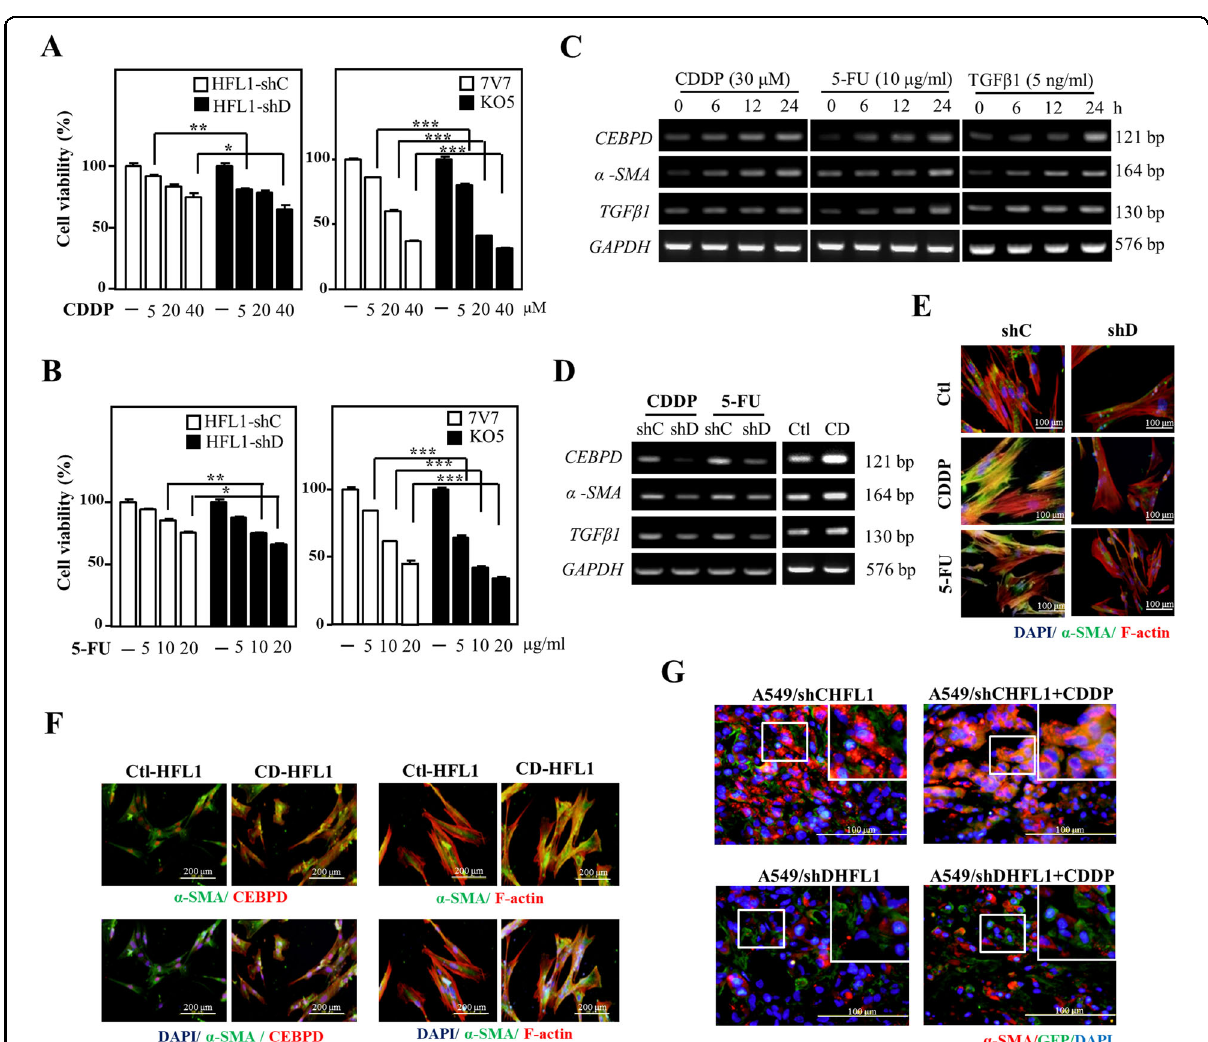
Fig. 1 CDDP and 5-FU induce CEBPD and contribute to myo fi broblast differentiation. A , B MTT assays were conducted to assess the cytotoxic effect of CDDP or 5-FU on HFL1, 7V7, and KO5 cells. HFL1 cells were infected with sh β -galactosidase (shC) or shCEBPD (shD) lentiviruses. Cells were seeded and their growth activity after treatment with CDDP or 5-FU for 24 h was compared. C An RT-PCR assay was performed with total RNA harvested from HFL1 cells treated with 30- μ M CDDP, 10- μ g/ml 5-FU, or 5-ng/ml TGF β 1. D HFL1 cells were infected with shC or shD lentiviruses and treated with or without CDDP or 5-FU for 6 h. For gain-of-function assays, total RNA was harvested from HFL1 cells infected with lentivirus bearing pAS3W-control (Ctl) or pAS3W-CEBPD expression vectors (CD). CEBPD , α -SMA , TGF β 1 , and GAPDH transcripts were examined via RT-PCR. E HFL1 cells were infected with shC or shD lentiviruses and treated with or without CDDP or 5-FU for 6 h. F HFL1 cells were infected with lentivirus bearing Ctl or CD expression vectors. α -SMA expression and the formation of actin stress fi bers were detected via immuno fl uorescence microscopy. G A549 cells mixed with HFL1 cells carrying a sh β -galactosidase knockdown vector with GFP (shC-GFP) or a CEBPD knockdown vector with GFP (shD-GFP) were inoculated subcutaneously into the dorsal rear fl anks of NOD-SCID mice, and the mice were treated with or without CDDP (5 mg/kg). The mice with A549-xenografted tumors were sacri fi ced in the 12th week. Tumor tissues were stained for α -SMA (red) and GFP (green), and nuclei were stained with DAPI (blue). Three independent experiments were performed in triplicate. All data are expressed as the mean ± S.D. Differences among groups were analyzed with one-way ANOVA followed by the Tukey ’ s multiple comparison test. * p < 0.05, ** p < 0.01, *** p <